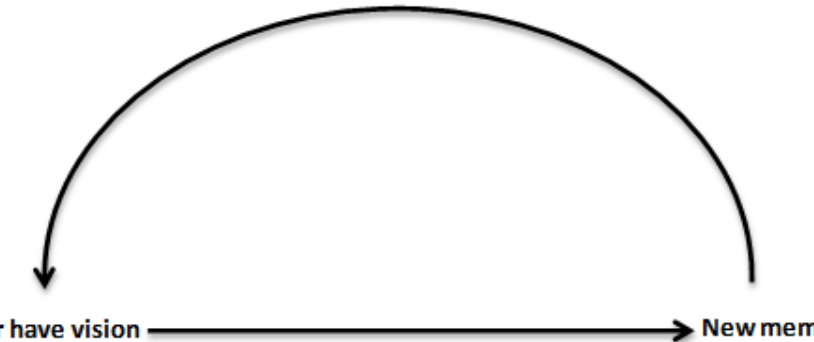
Figure 4. A Causal Loop. 9.